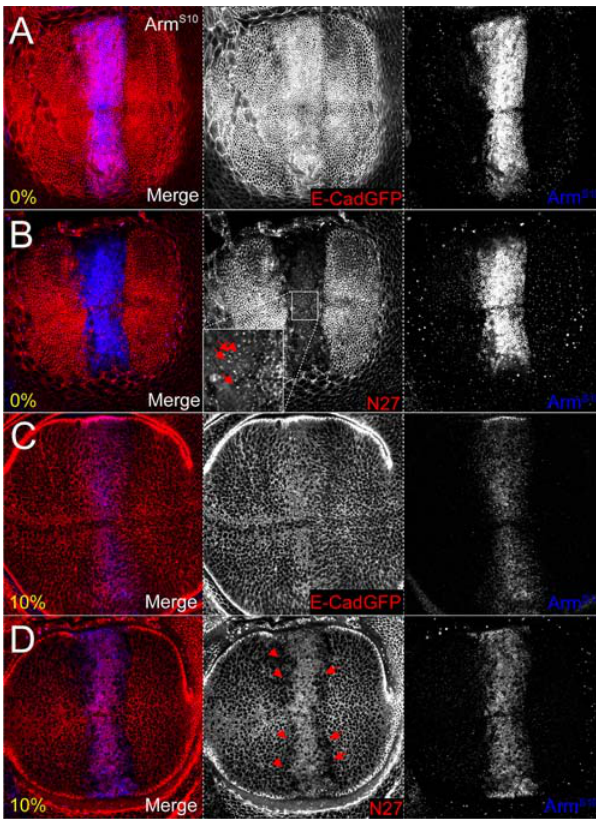
Figure 8. Stability of UAS constructs determines the strength of association of endogenous protein with the AJ. (A) D NArm 1– 128 excludes endogenous Armadillo (red channel, absence of staining) only at the strongest levels of dppGAL4 expression, away from the A/P boundary (denoted by white line). (B) As with Arm S10 , D NArm 1–155 competes with endogenous Armadillo at the AJ (AJ) within the entire domain of dppGAL4 expression, abutting the A/P boundary. However, some endogenous Armadillo remains (red, inset), and the construct is more diffusely associated with the AJ (blue, inset). The construct is also more diffusible, as demonstrated by the extent of its spread into more anterior AJs. (C) The myriostylation signal prevents Myr- D NArm 1–155 from effectively binding in the AJ, allowing endogenous Armadillo to accumulate (red, inset), although it is strongly expressed both apically and basally in the membrane (blue, inset). (D) The C-terminal deletion Arm D C XM19 is stable in the AJ, likely entirely excluding the endogenous protein. This is not verifiable with the available antibodies which detect both the construct and the endogenous Armadillo. Unlike in the other experiments, the protein(s) also accumulate at the D/V boundary.